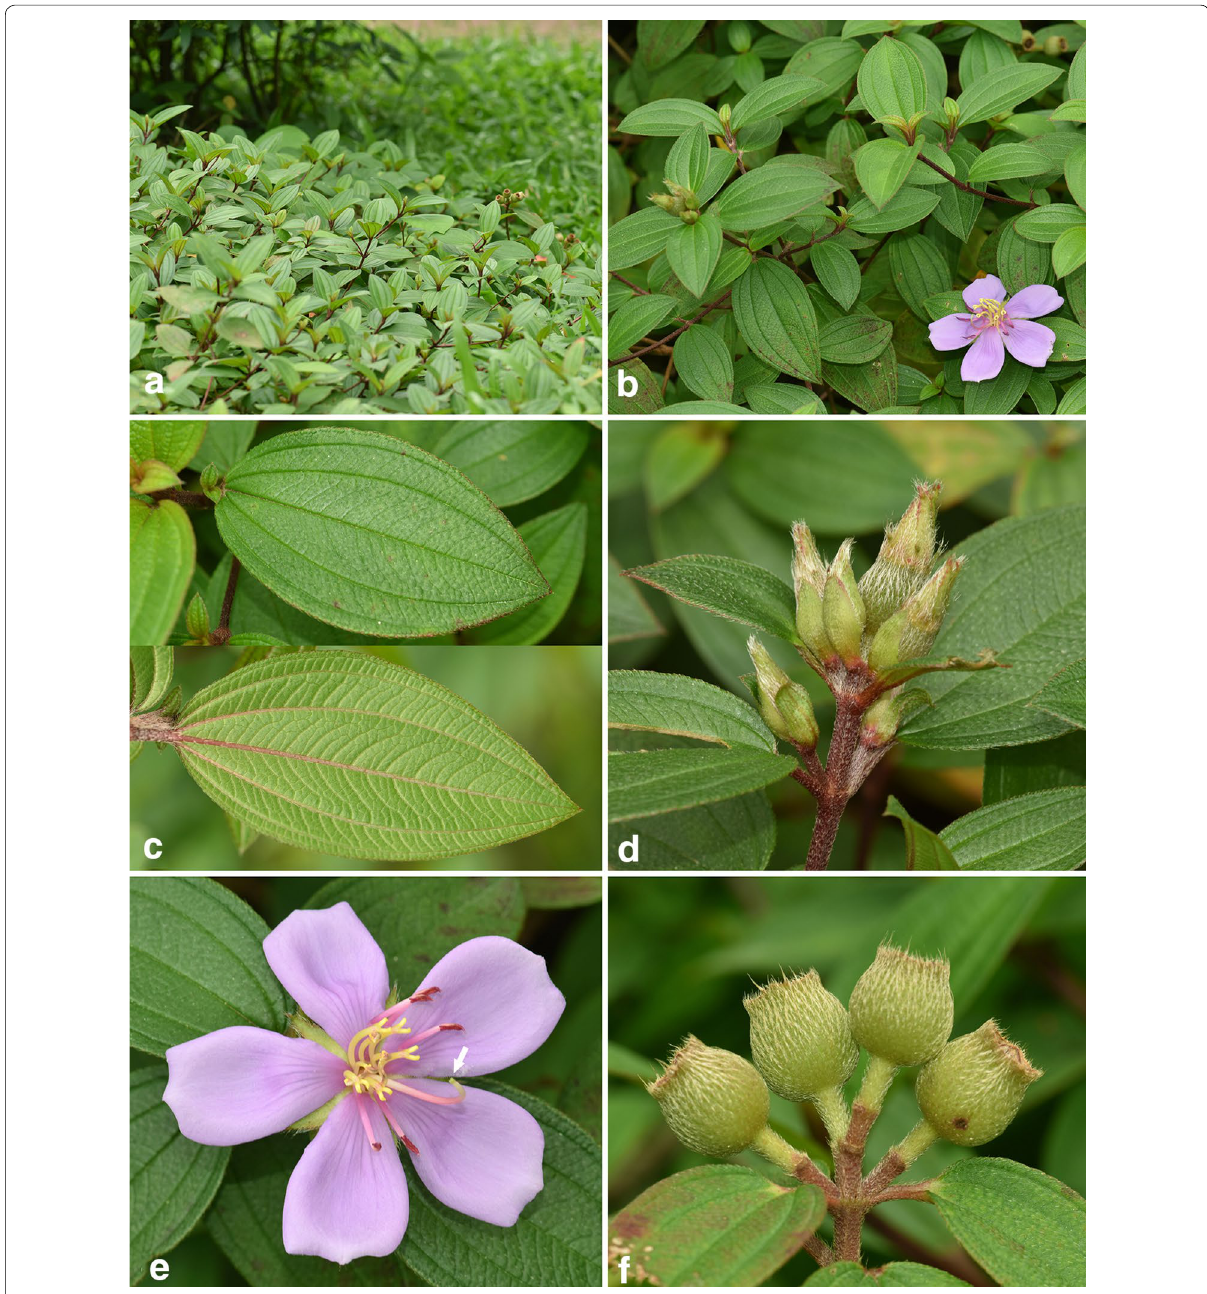
Fig. 2 Melastoma intermedium Dunn. a Habit; b flowering branches; c adaxial and abaxial surface of leaf; d bracts on the inflorescence; e flower, arrow indicated the position of stigma; f young fruits showing the appressed